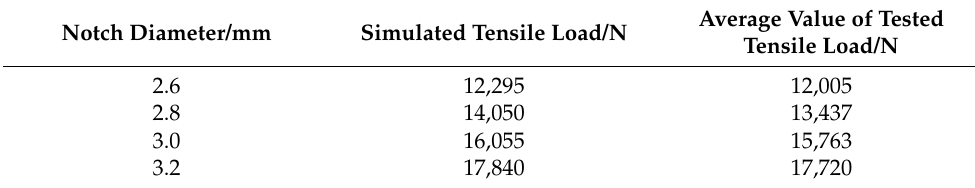
Table 6. Comparison of simulation and test results for different notch bottom